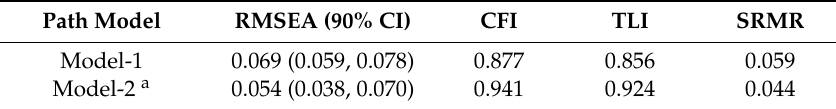
Table 3. Summary for HB-Bloat-M model fit indices ( n = 323).